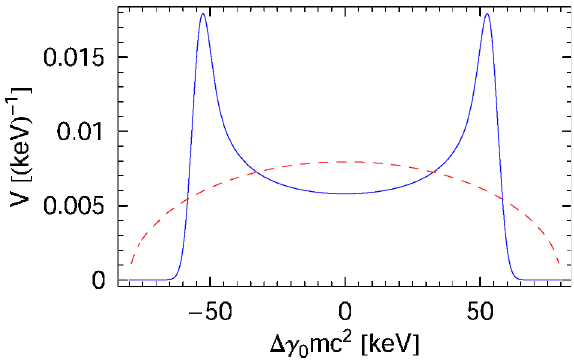
FIG. 8. (Color) Electron energy distribution after the laser heater for a large laser spot (blue solid curve) and for a matched laser spot (red dashed curve). The laser powers are given in Table II so that the rms energy spread (cid:27) both